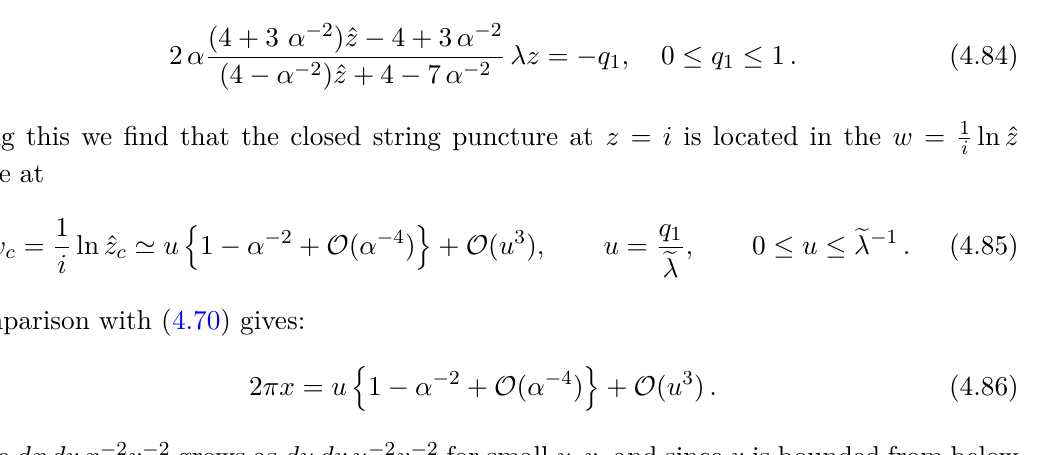
Figure 8 . This figure shows the different regions of the moduli space covered by different Feynman diagrams of figure 7. The regions are marked by keeping only the leading order term in the expansion in powers of α − 2 and e λ − 2 ; the subleading corrections can be found in the text. Also, using (4.3), (4.68), the sewing relation takes the